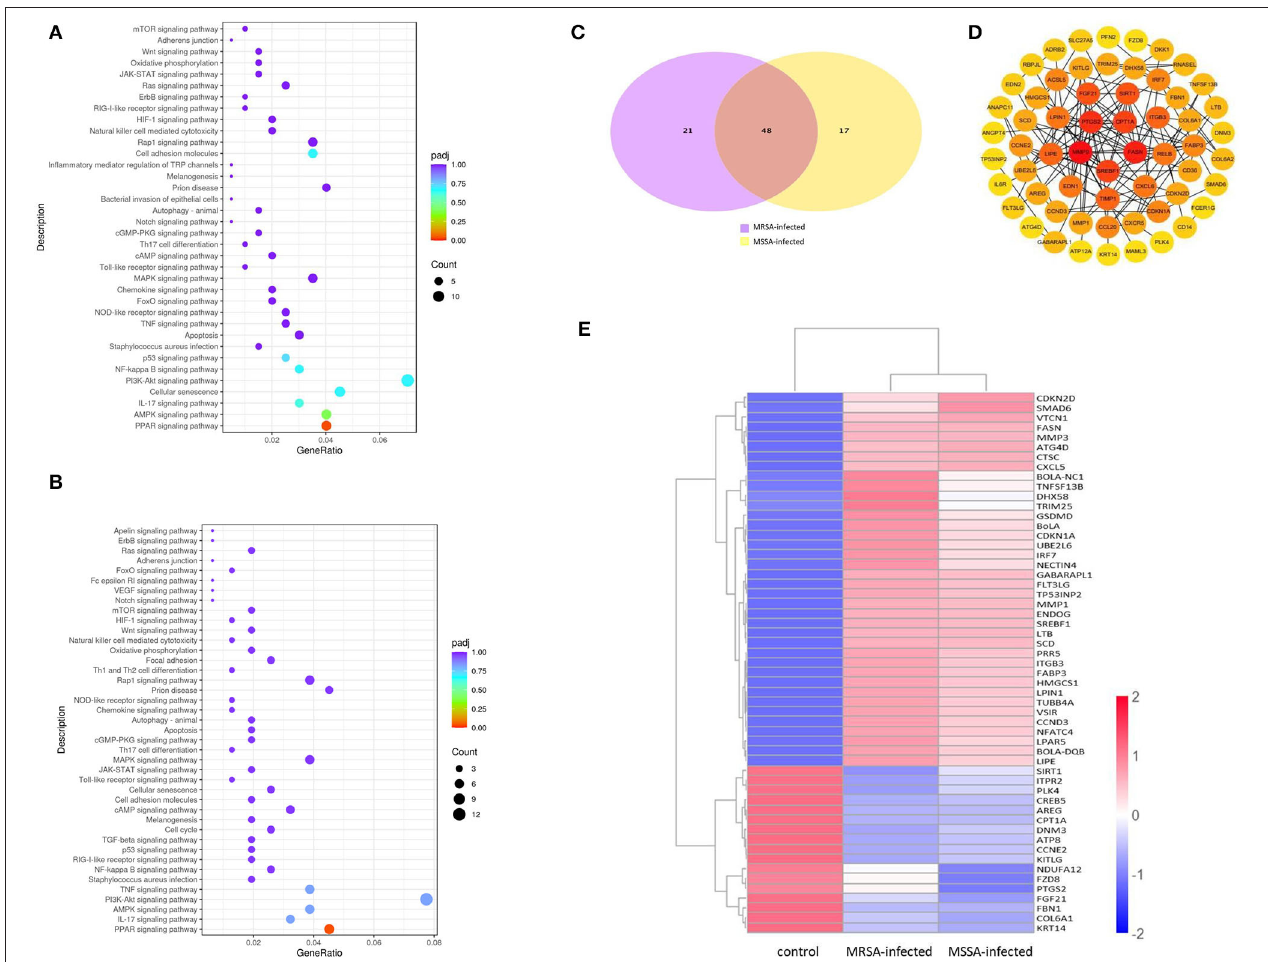
FIGURE 4 | The enrichment analysis of selected DEGs in MRSA and MSSA infection groups. (A) and (B) The KEGG enrichment analysis of selected DEGs in MRSA and MSSA infection groups. (C) The Venn diagram of screening DEGs. Purple indicates MRSA-infected, yellow indicates MSSA-infected. (D) The interaction network map of important DEGs. (E) The clustering of important differentially expressed genes. Red represents highly expressed genes and blue represents lowly expressed